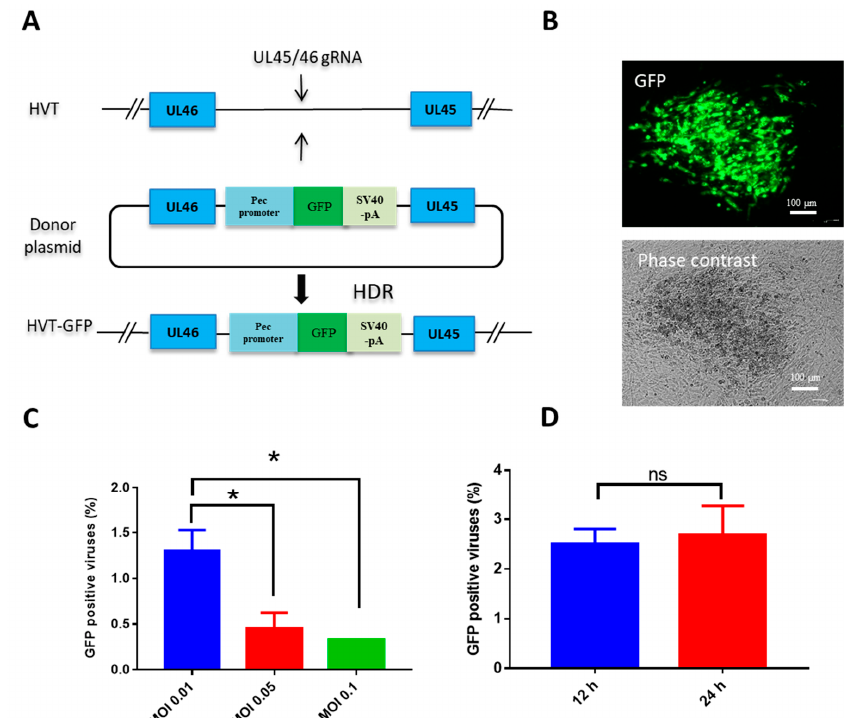
Figure 1. Optimization of gene knock-in via CRISPR / Cas9-induced homology-directed repair (HDR) repair. ( A ) Schematic of insertion of green fluorescent protein (GFP) expression cassette between turkey herpesvirus (HVT) UL45 and UL46; ( B ) HVT–GFP plaque under UV excitation or phase contrast; ( C ) the efficiency of GFP cassette knock-in with different HVT infection doses; ( D ) the efficiency of GFP cassette knock-in with different infection times post-transfection. Data shown represent the mean of three replicates. One-way ANOVA (Figure 1C) and paired Student’s t -test (Figure 1D) were used to test differences between different groups. Error bar = standard error of mean. * p < 0.05; ns = not significant; MOI = multiplicity of infection.